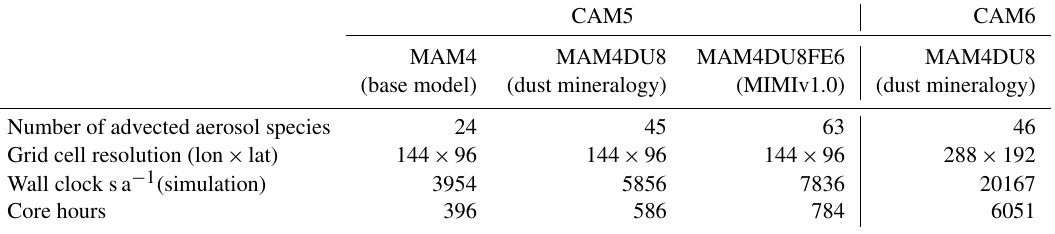
Table 6. Simulation time (in seconds per simulated year) for the CESM-MAM4 model. The CAM5 base model, with the addition of dust mineralogy and with the addition of dust mineralogy and iron processing (i.e. MIMI v1.0), is shown. The cost of running the new higher- resolution CAM6 model with dust mineralogy is also shown for comparison. All CAM5 simulations were executed on 10 nodes with 36 cores per node for 2 years (2006–2007) with consistent output fields. CAM6 simulations are executed on 30 nodes with 36 cores per